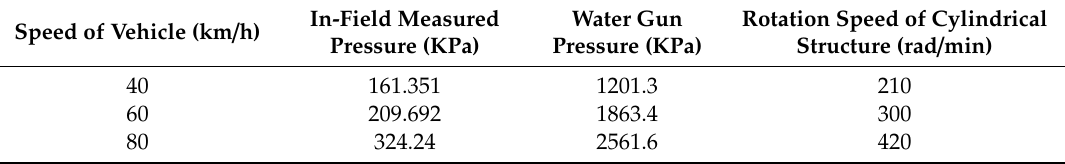
the cylindrical Table 8. Corresponding relationship between vehicle and water gun pressure and the rotation speed of the cylindrical structure.